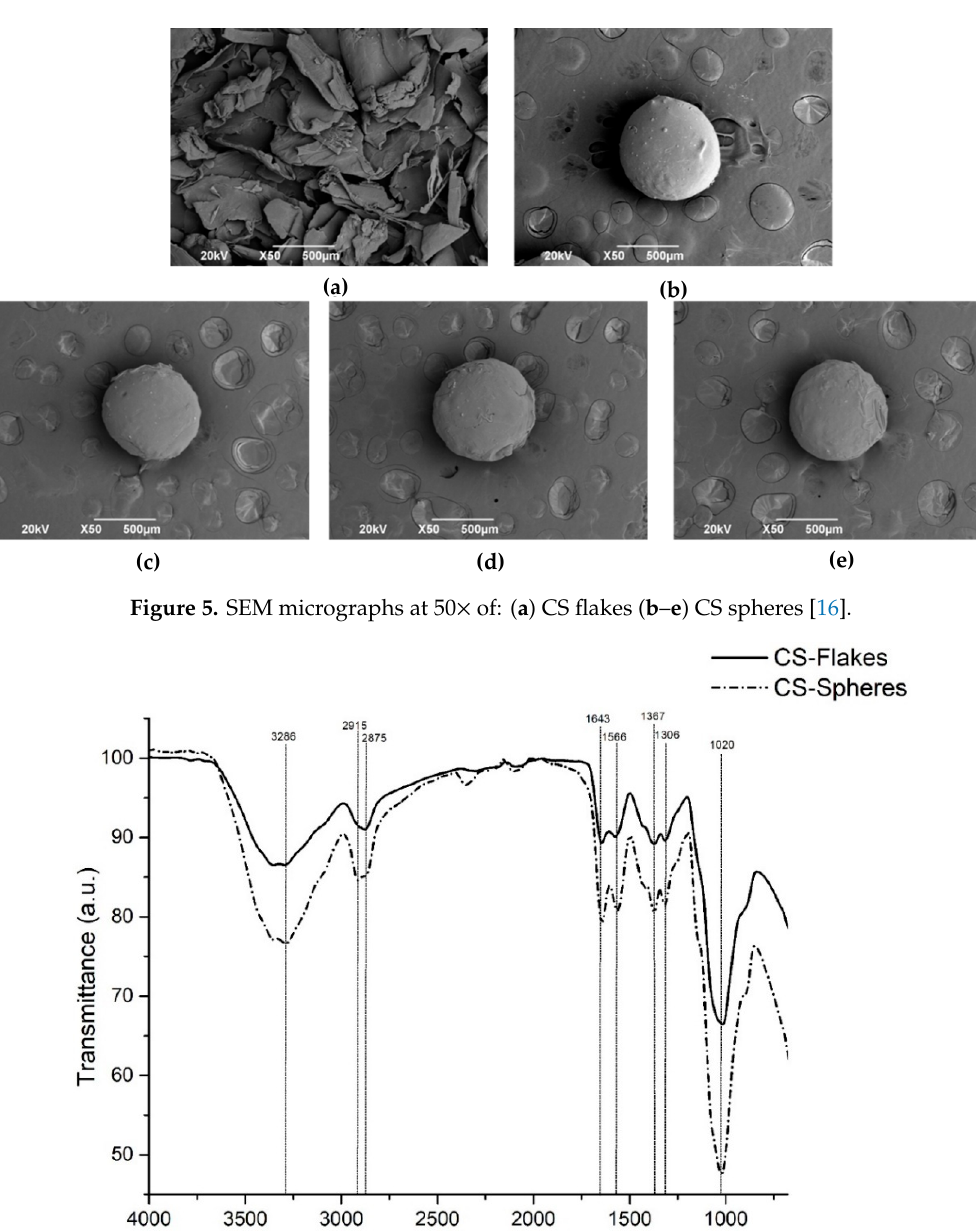
Figure 5. SEM micrographs at 50× of: ( a ) CS flakes ( b–e ) CS spheres [16].